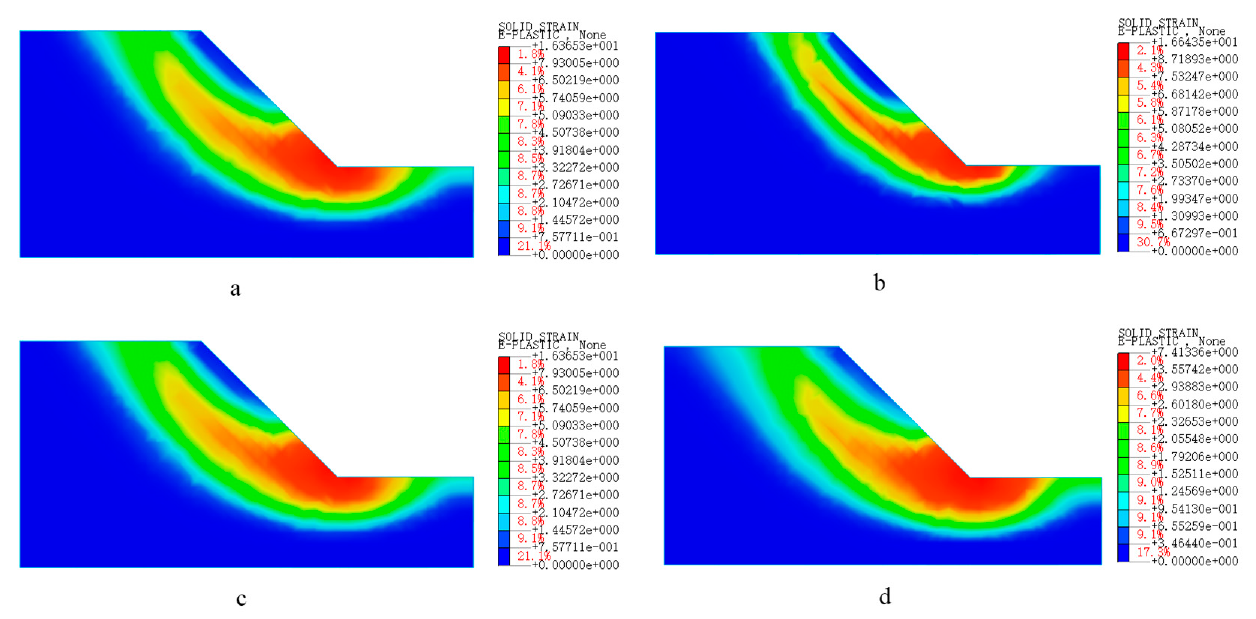
Figure 7. Equivalent plastic strain of slopes supported by tap roots with different lengths: ( a ) Bare slope, ( b ) 2 m tap root, ( c ) 3 m tap root, ( d ) 4 m tap root.